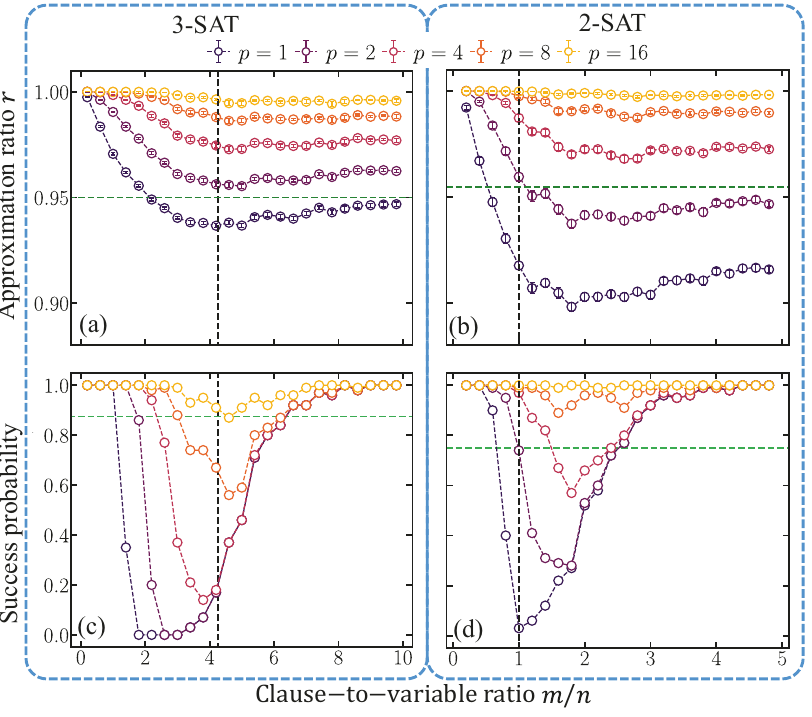
Fig. 4 Accuracy of QAOA in k -SAT. a , b Approximation ratio r of SAT clauses, ( c , d ) Success probability in determining SAT/UNSAT for 3-SAT (left) and 2-SAT (right) versus clause-to-variable ratio m / n with n = 10 variables. Green dashed line represent the lower bound of approximation algorithm r ≥ 0.95 for Max-3-SAT 37 and r ≥ 21/22 for Max-2-SAT 11 . The horizontal light green dashed line in ( c , d ) represent the success probability of the random guess which are 7/8 and 3/4 for 3-SAT and 2-SAT separately. Vertical black dashed lines in all plots represent critical point of SAT-UNSAT transition. All results and error bars are estimated over 100 instances.